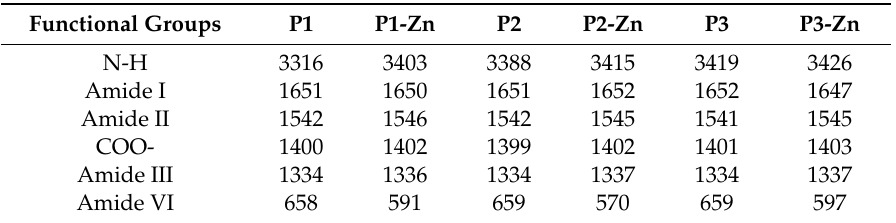
Table 3. Wavenumber (cm − 1 ) of band shifts observed in the FTIR spectra of three molecular weight peptide fractions and their zinc